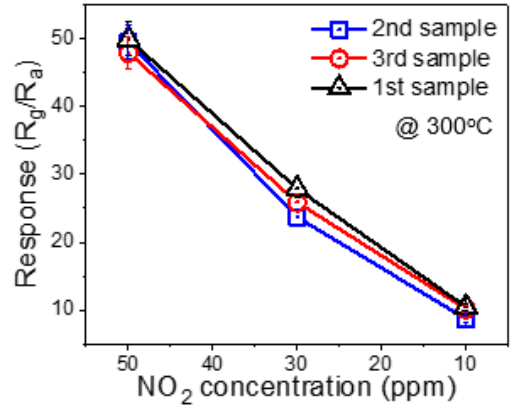
Figure 12. Reproducibility of optimized gas sensor.